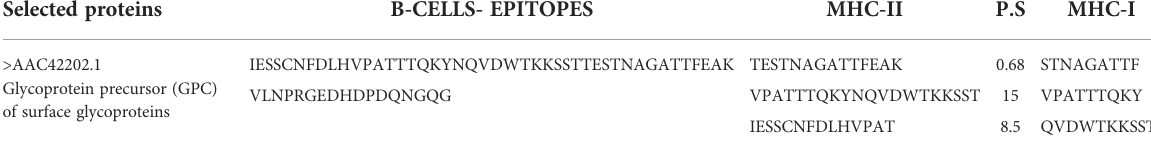
TABLE 1 Predicted B cell peptide epitopes and T cell epitopes with the least percentile score (P.S). Selected